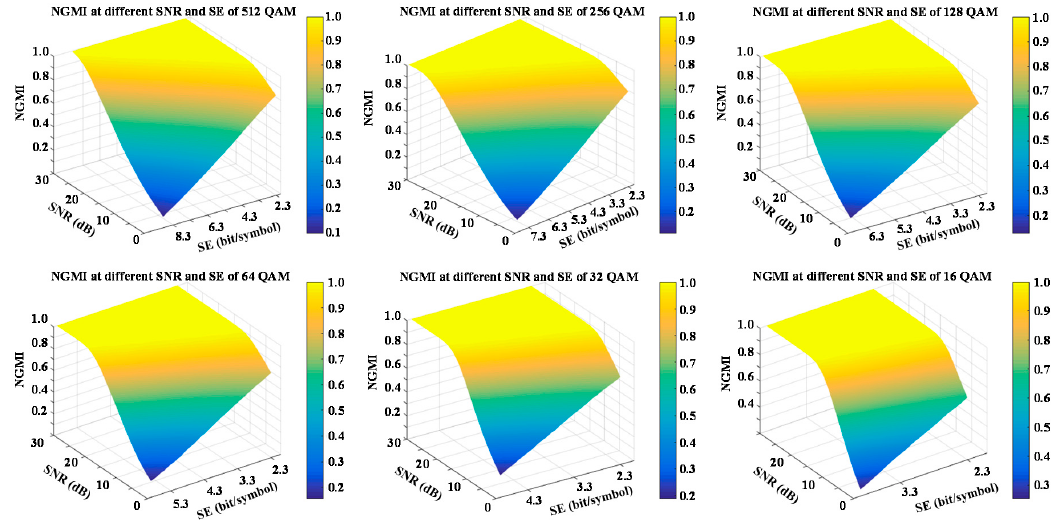
Figure 2. Relationship between normalized generalized mutual information (NGMI), source entropy (SE), and signal-to-noise ratio (SNR) with different probabilistic shaping (PS) QAM order of 16, 32, 64, 128, 256, and 512.